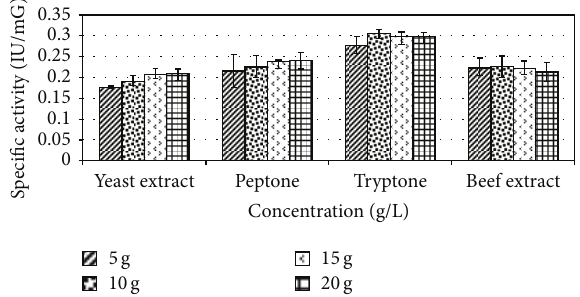
Figure 10: Effect of various metal ions on specific ADI activity. Results are expressed as the mean ± S.D ( 𝑛 = 3 ), 𝑃 -value < 0.05.